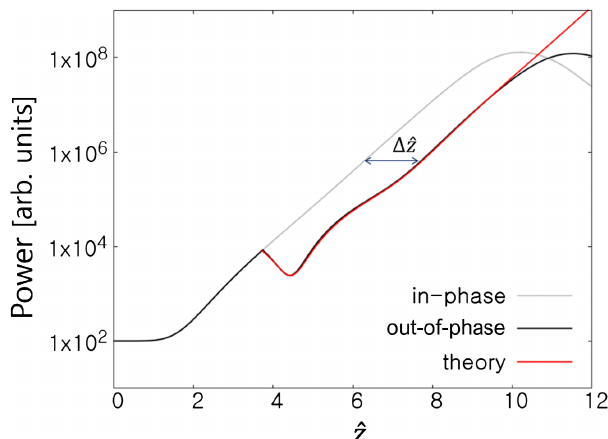
FIG. 1. FEL gain curves of the in-phase and the out-of-phase conditions from the 1D steady state simulation and theory. The phase is shifted by a phase shifter located at ˆ z 0 ¼ 3 . 74 . The shifted distance of the gain curve from the simulation is Δ ˆ z ¼ 1 . 27 , which agrees with the theoretical